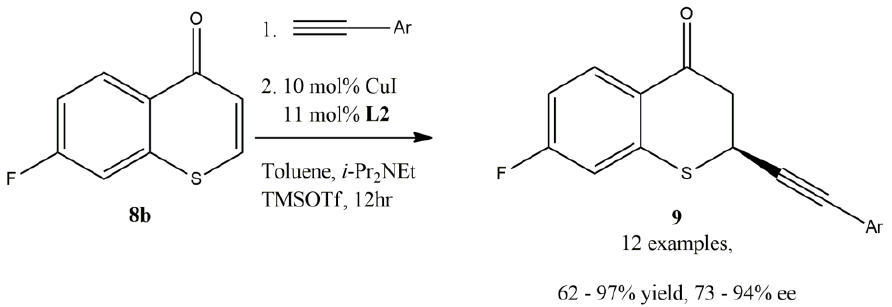
Figure 12. The scope of arylacetylenes for the enantioselective Cu-catalyzed alkynylation of thio- chromones.